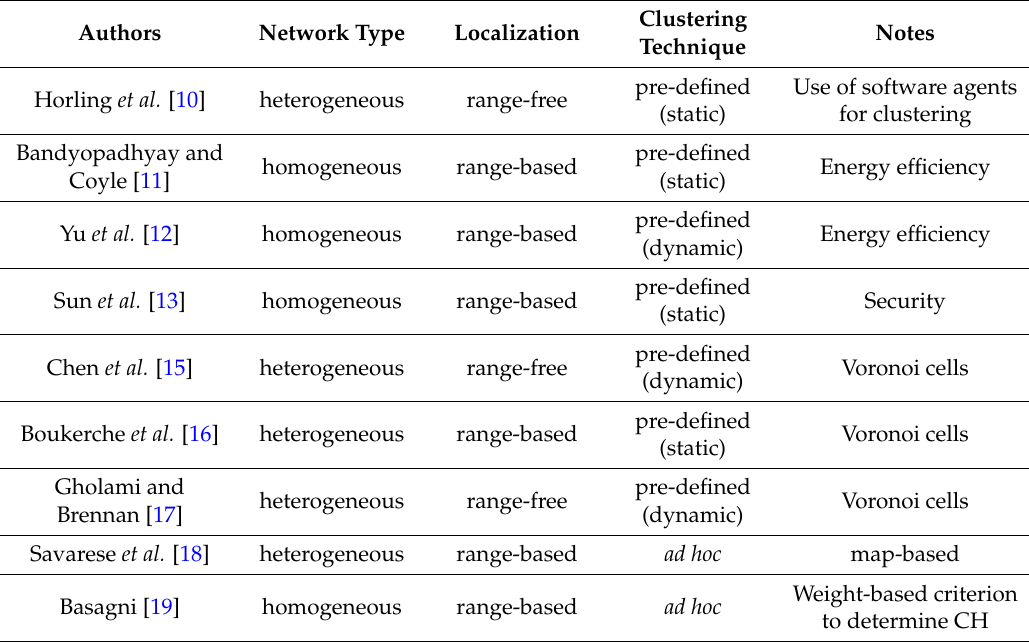
Table 1. Recent work on wireless sensor node clustering